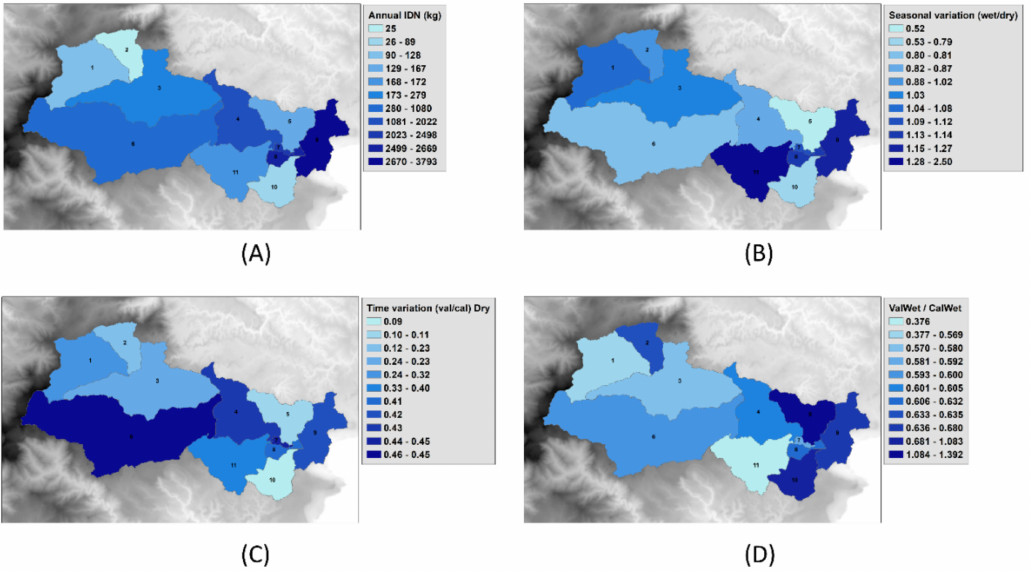
Figure 12. IDN contribution maps. ( A ) Average annual total sediments, ( B ) seasonal variation (ratio of wet to dry), ( C ) time variation (ratio of validation to calibration periods) for the dry season, and ( D ) time variation (ratio of validation to calibration periods) for the wet